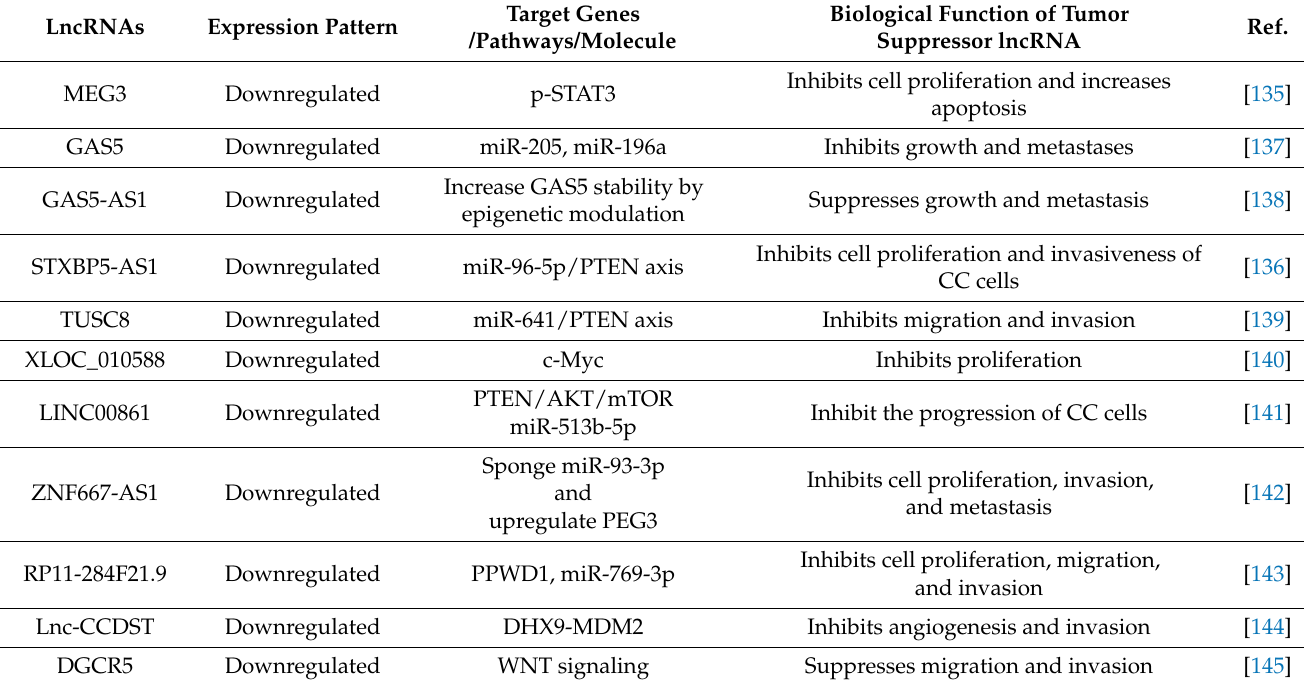
Table 4. Summary of selected tumor suppressor lncRNAs with their functional effects in